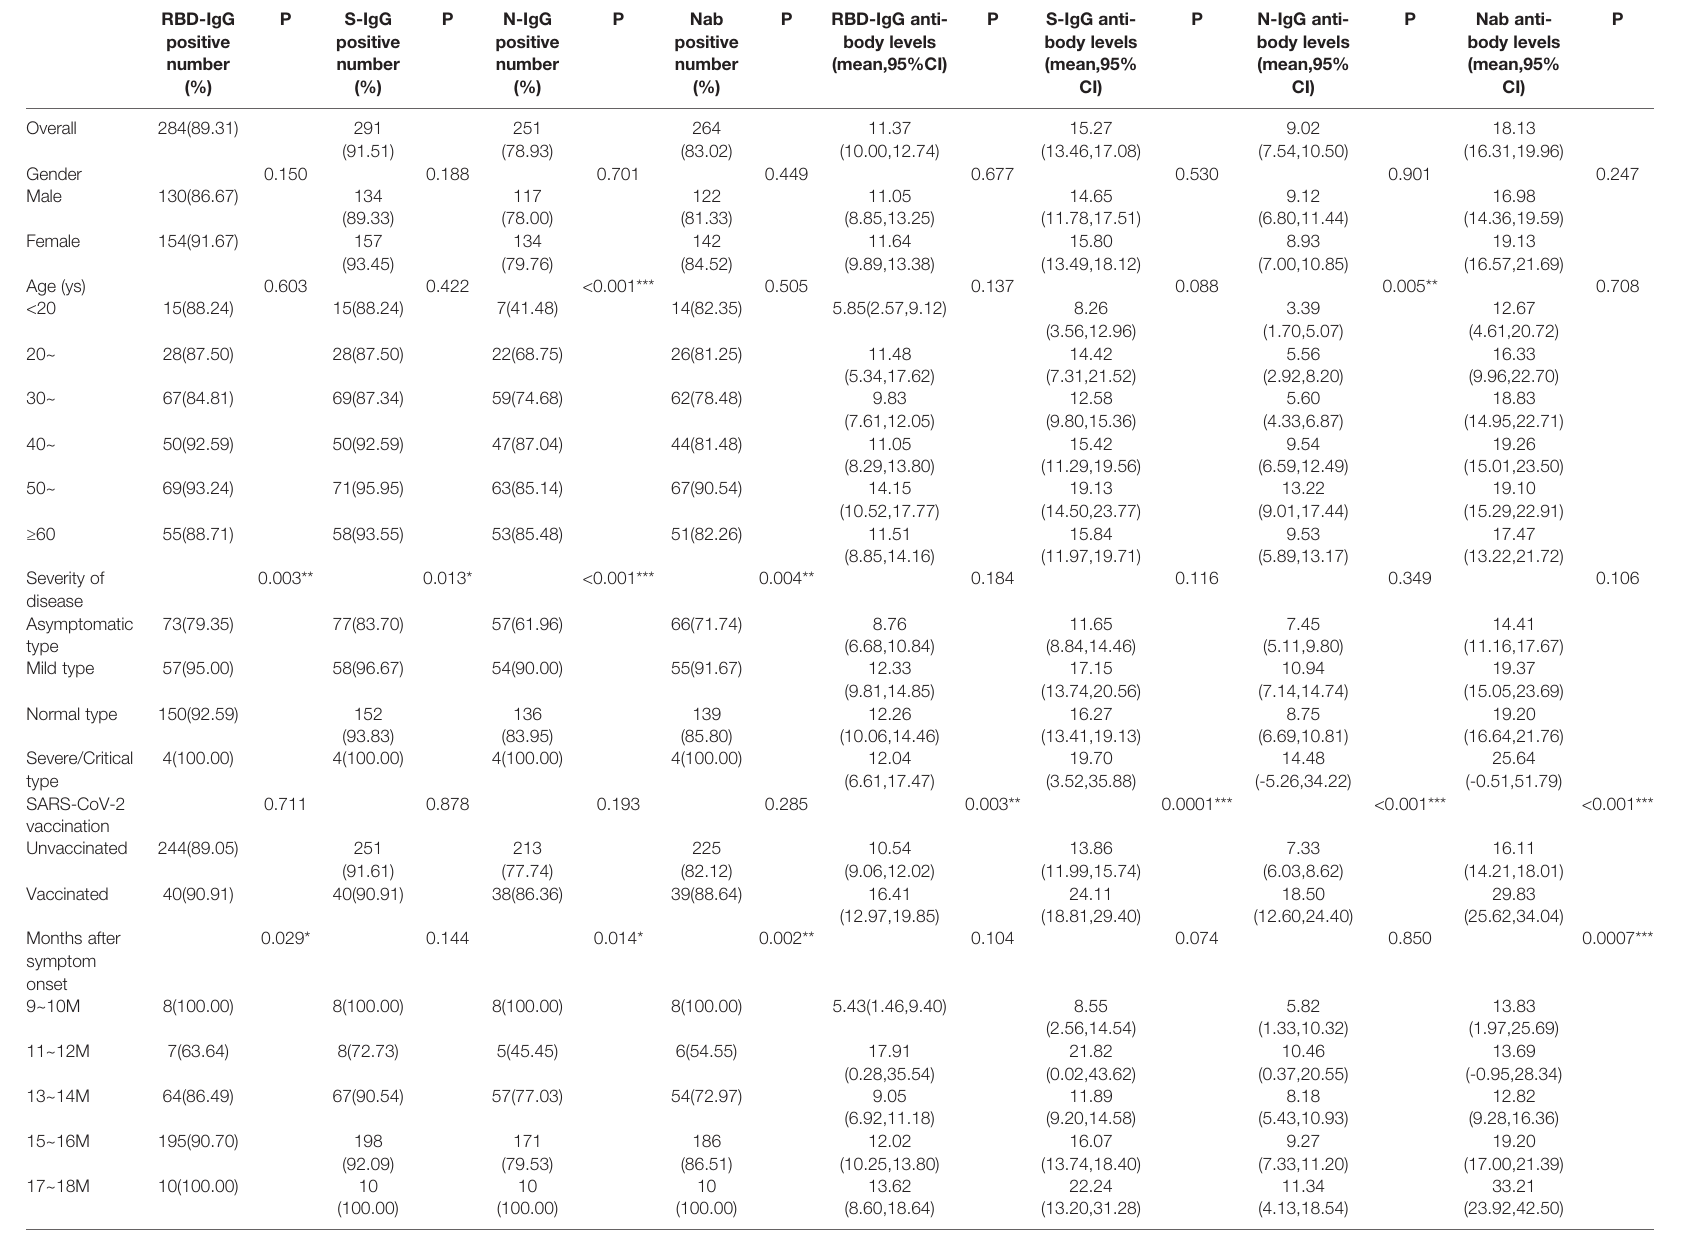
TABLE 4 | Distribution of positive rates and antibody levels for IgG subtypes and neutralizing